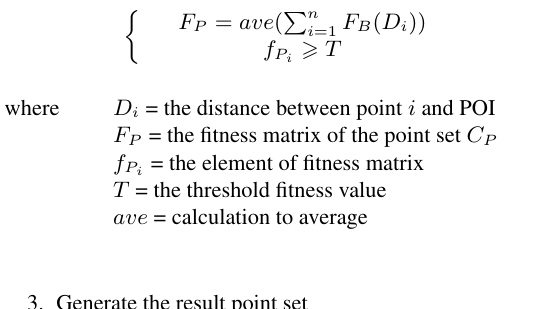
With linear fitting method, we have the fitting equation below,